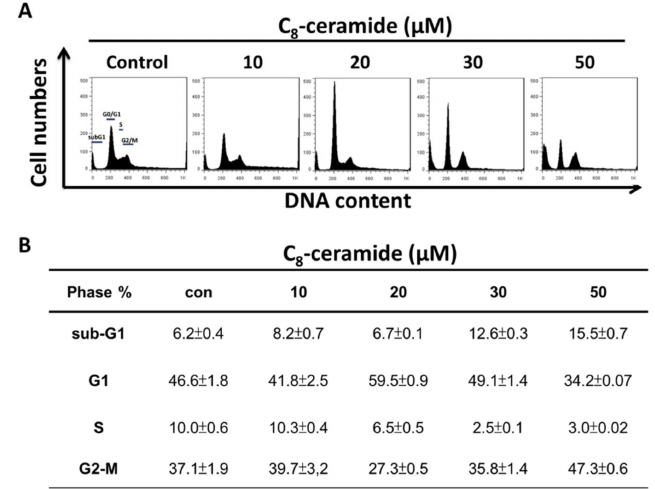
Figure 2. C 8 -ceramide-induced cell arrest of G1 in H1299 cells. Cells were treated with indicated concentrations (from 10 to 50 µ M) of C 8 -ceramide for 24 h respectively. ( A ) Representative cell cycle distribution in C 8 -ceramide-treated H1299 cells. (B) The results of quantitative analysis. C 8 -ceramide induces the apoptosis of H1299 cells in a dose-dependent